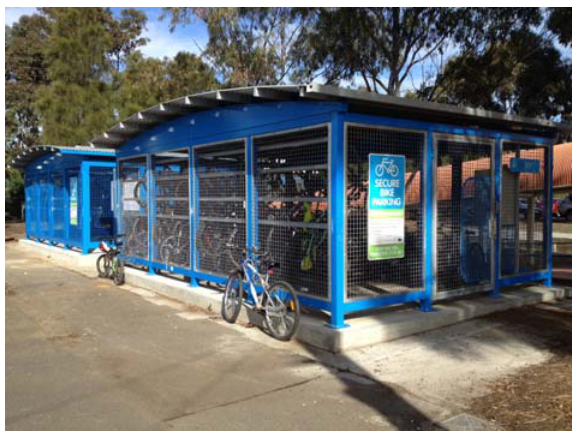
Figure 8. Bicycle parkiteer situated at a train station. Photo attributed to Bicycle